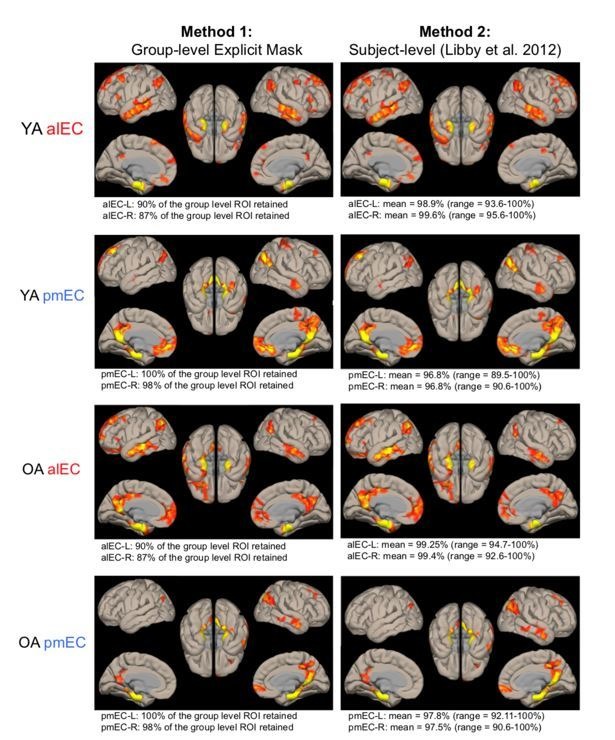
Comparison of signal drop out methods for the alEC and pmEC seeds, and their resulting functional connectivity maps.Functional connectivity maps for Method 1 (group-level explicit mask, see Author response image 1) and Method 2 (subject-level from Libby et al., 2012) of removing signal drop out from alEC/pmEC seeds were nearly identical. Quantification of voxels retained is shown below each image. Due to the similarity of the methods, and wanting consistency with the EC seed, we used Method 2 in the manuscript.